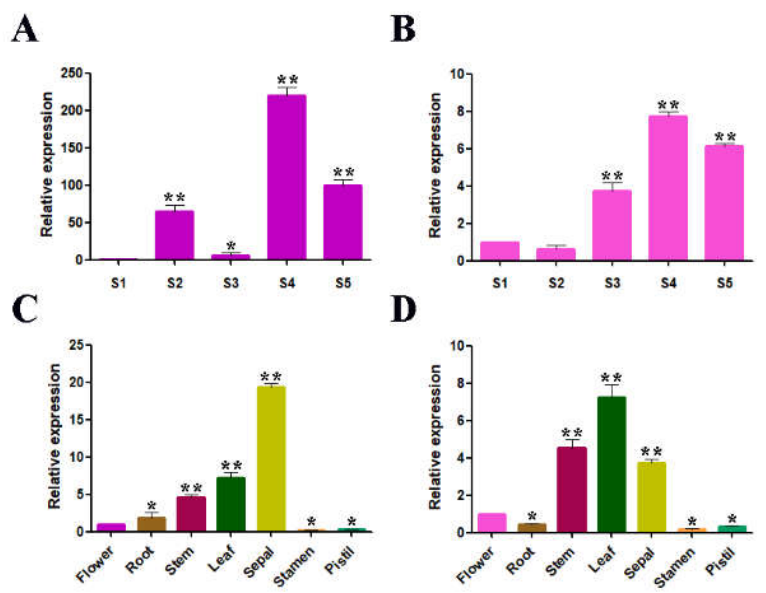
Figure 3. Temporal and spatial expression patterns of RrGT2 . Relative expression of the RrGT2 and RdGT2 gene during the five flowering stages of R. rugosa ‘Zizhi’ ( A ) and R. davurica ( B ). S1, budding stage; S2, initial opening stage; S3, half opening stage; S4, full opening stage; S5, wilting stage. Relative expression of the RrGT2 and RdGT2 gene in seven different tissues of R. rugosa ‘Zizhi’ ( C ) and R. davurica ( D ). The error bars represent the SDs of triplicate reactions. The experiment was repeated three times and each yielded similar results. * p < 0.05 and ** p < 0.01 indicate significant differences between different flowering stages and between different tissue types.